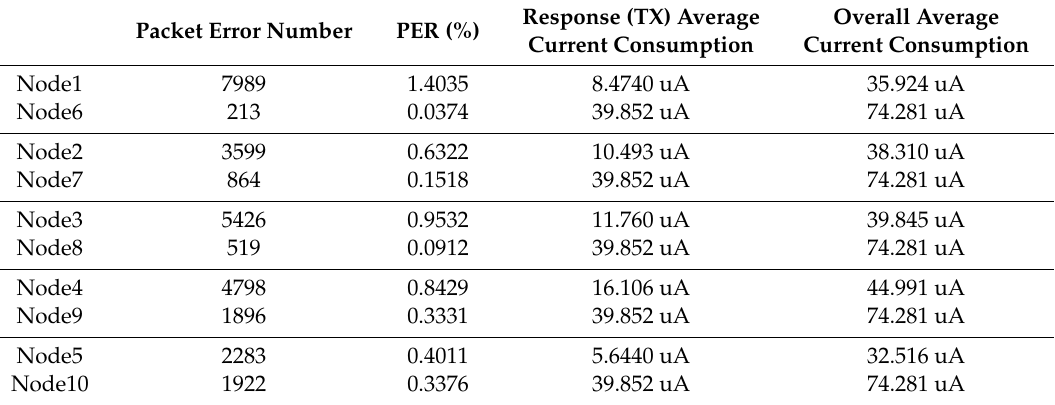
Table 4. Node experimental results.